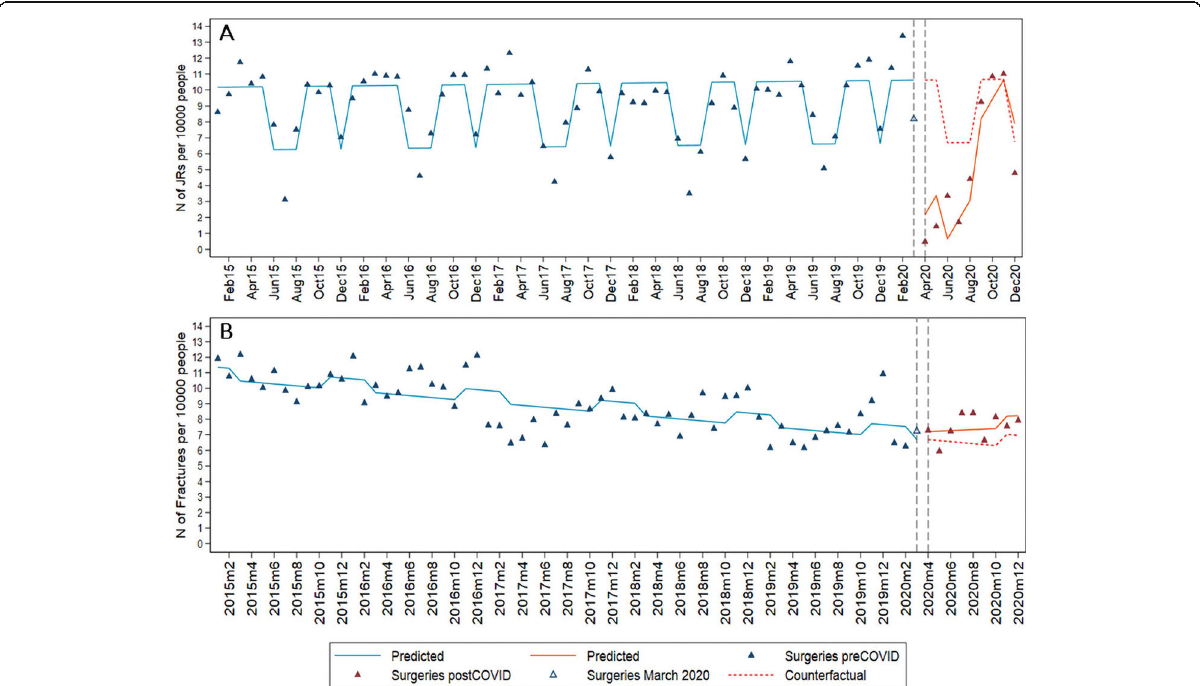
Fig. 3 Monthly incidence of surgeries per 10,000 Skåne inhabitants aged ≥ 70. a Interrupted time series for JR, c arthroscopies, and d fracture